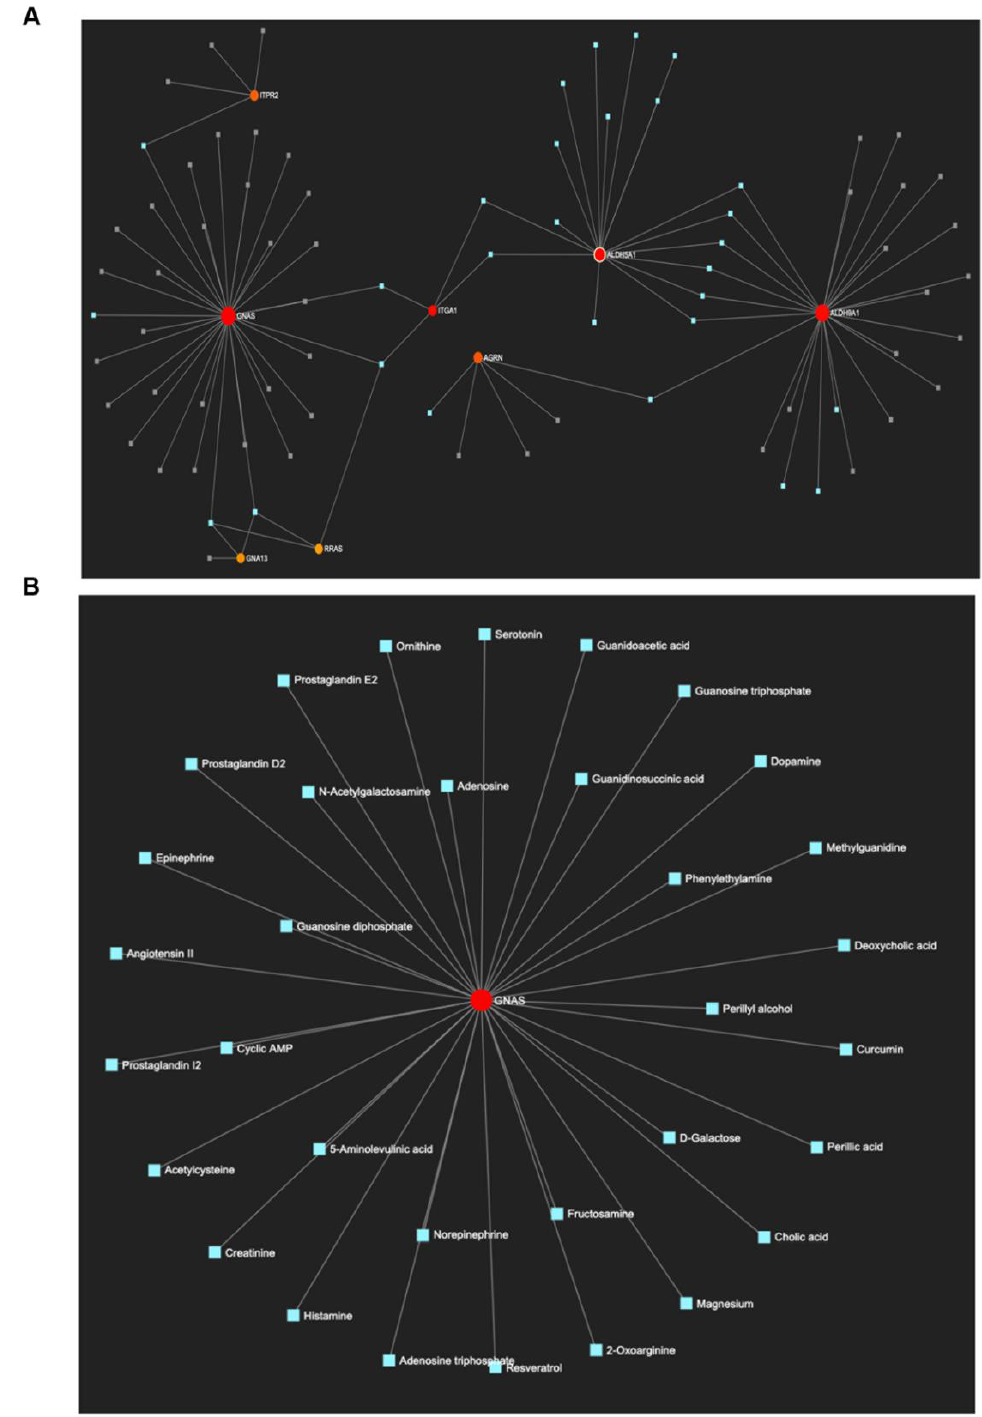
Figure 5. Gene–metabolite associations for selected DEPs involved in the enriched pathways of oxy-exposed neuroglial Figure 5. Gene – metabolite associations for selected DEPs involved in the enriched pathways of cultures. ( A ) Overall gene–metabolite network. ( B ) Highlighted network of metabolites associated with the GNAS oxy-exposed neuroglial cultures. ( A ) Overall gene – metabolite network. ( B ) Highlighted network gene of metabolites associated with the GNAS gene locus.